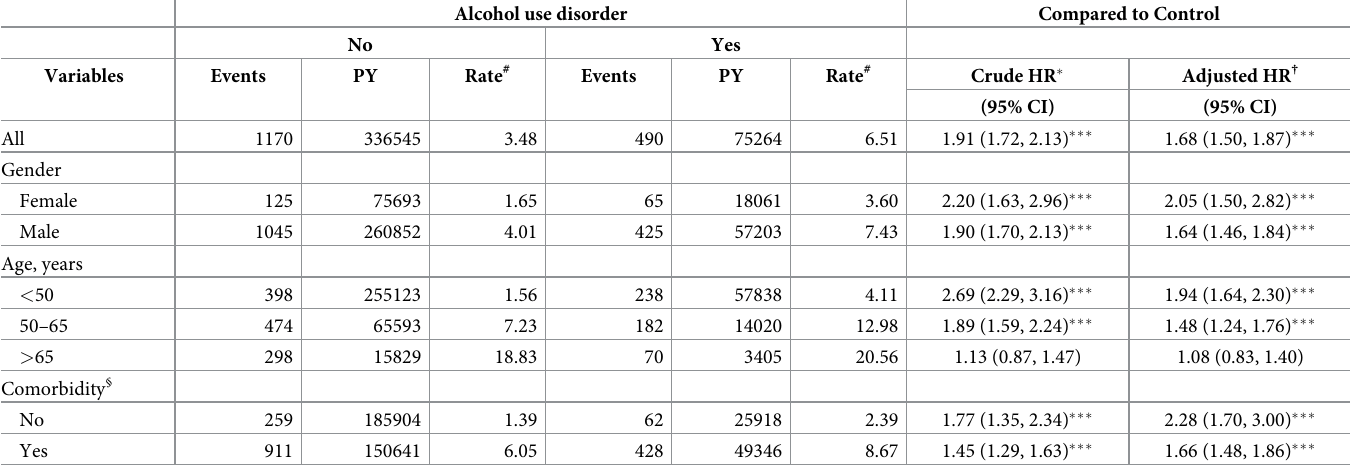
Table 3. Incidence and adjusted hazard ratio of developing chronic kidney disease and person-years by gender, age and comorbidity for patients with alcohol use disorder in comparison to the control cohort. Alcohol use